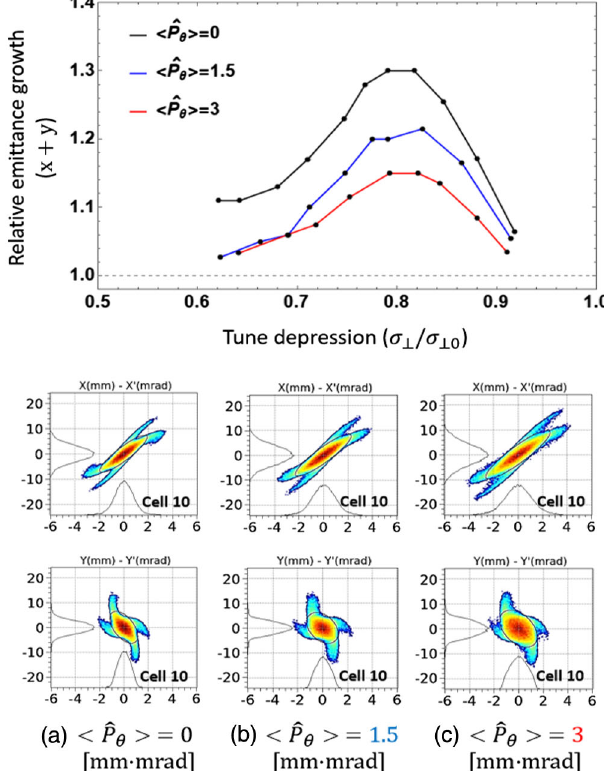
FIG. 5. Relative emittance growth over ten periods along the quadrupole focusing lattice for σ ⊥ 0 ¼ 100 ° without acceler- ation. Emittance growth results mainly from the fourth-order particle resonance. The phase-space plots at cell 10 are ˆ P 0 , (b) h ˆ P 1 . 5 , and (c) h ˆ P shown for (a) h θ i ¼ θ i ¼ θ i ¼ 3 mm mrad beams for a tune depression of σ = σ 0 . 82 ⊥ ⊥ 0 ¼